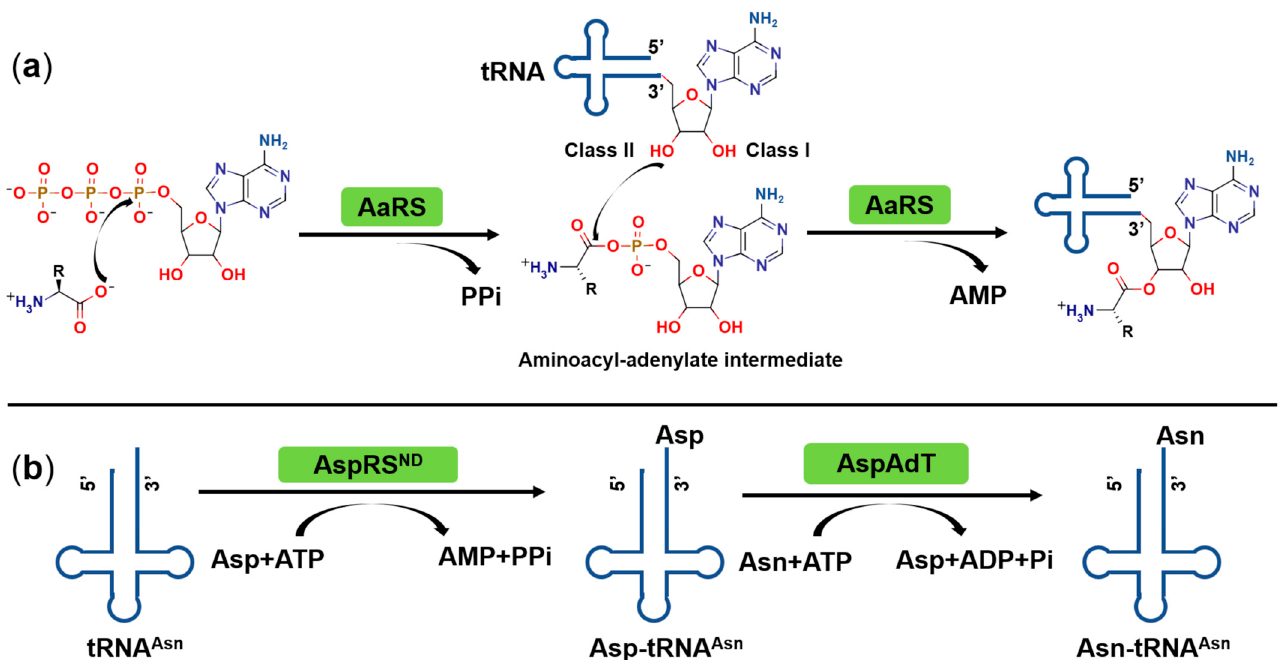
Figure 1. Catalytic mechanisms for the standard ( a ) and indirect ( b ) aminoacylation reaction.